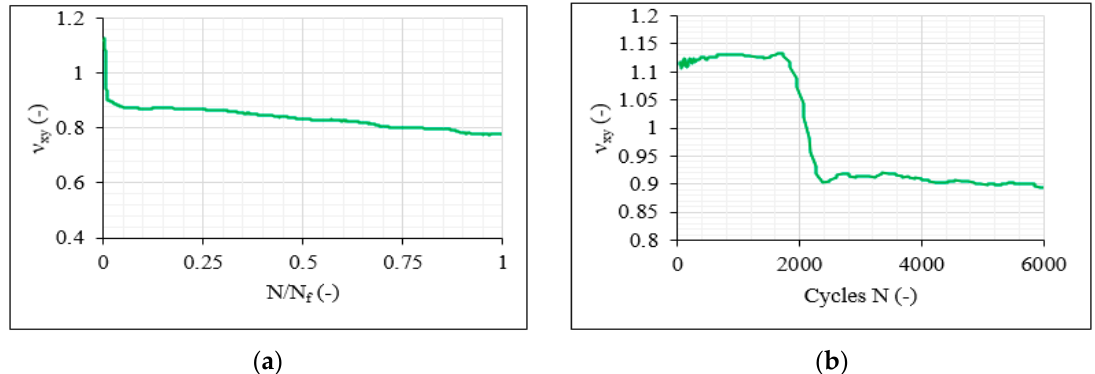
Figure 25. ν xy evolution ( a ) versus the normalised fatigue life and ( b ) during the first fatigue 6 × 10 3 cycles for one [0°/30°/0°/ − 30°] s laminate for the 70%-0.1 test.